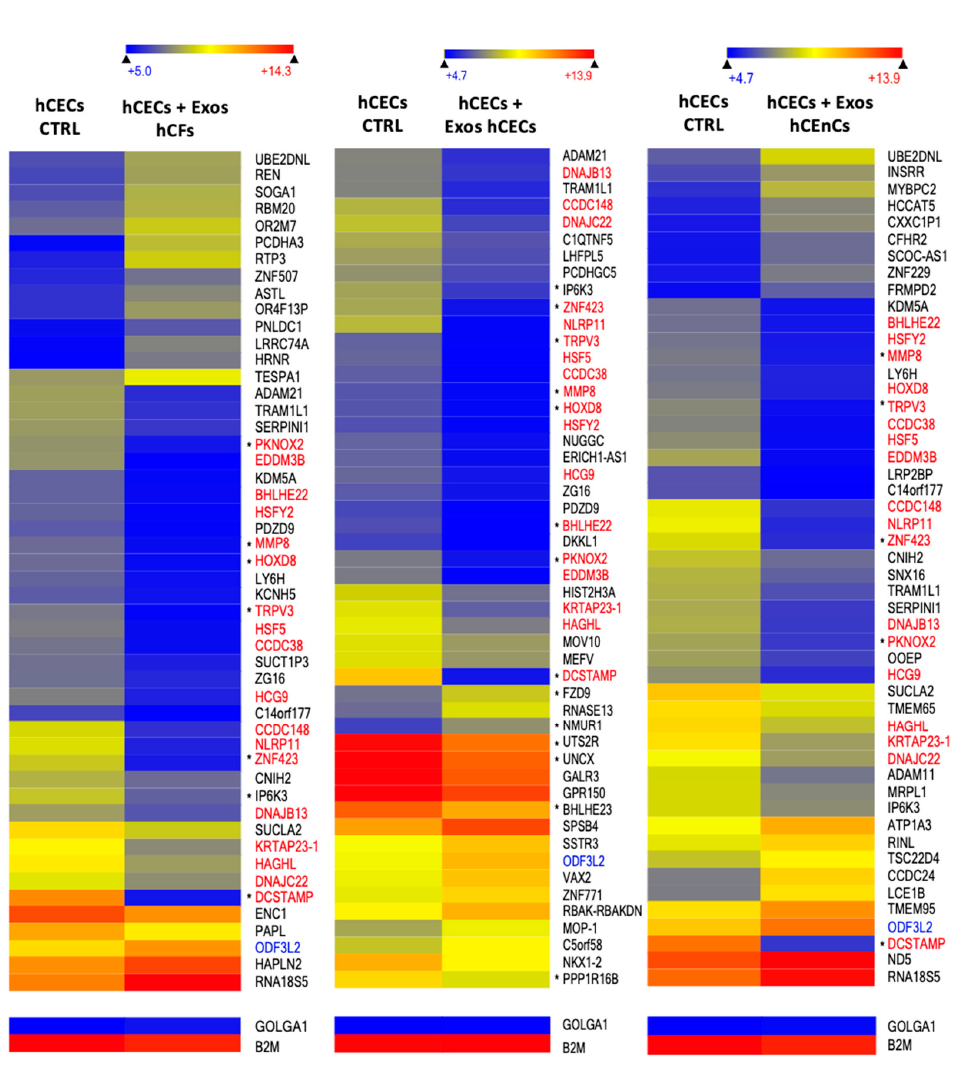
Figure 7. Gene expression pattern of hCECs cultured in the presence of hCFs-, hCECs- or hCEnC- exosomes. Heatmap representation of the 50 most differentially regulated genes in hCECs CTRL (no added exosomes) against hCECs + Exos hCFs (first heatmap), hCECs + Exos hCECs (second heatmap) or hCECs + Exos hCEnCs (third heatmap). Gene names indicated in red correspond to genes whose transcription are commonly downregulated in all three conditions whereas those in blue are upregulated. An asterisk placed before the gene name indicates that this gene has been associated with at least one function of interest in the IPA analysis. Microarray data for the golgin subfamily A member 1 (GOLGA1) and β 2-microglobulin (B2M) housekeeping genes that are expressed, respectively, at low and very high levels in all cell types are also shown.